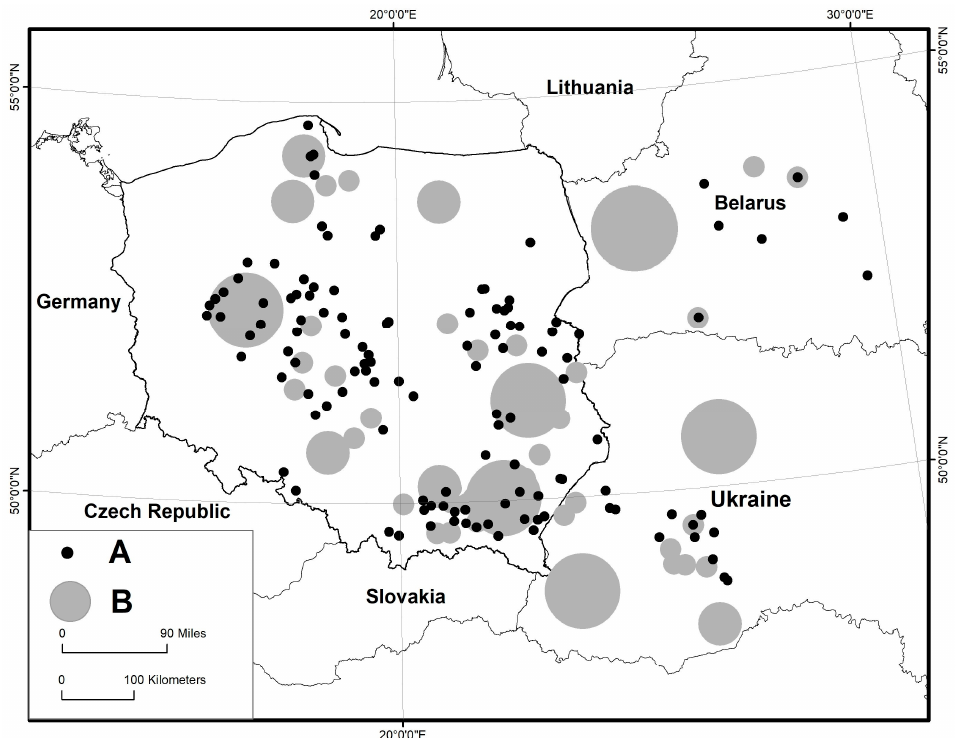
Figure 1. The distribution of records for dyes of organic origin in our study; A—places, B—regions.